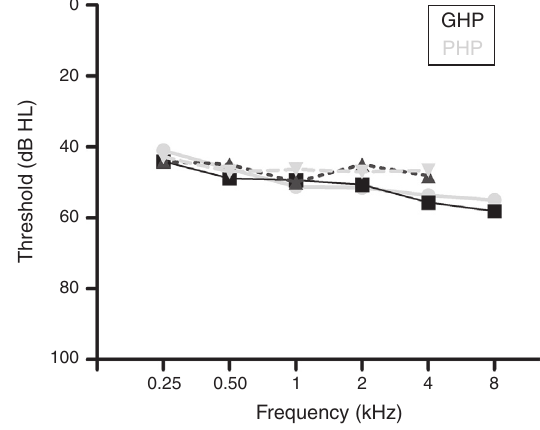
Audiograms of good and poor hearing aid perform- ers.